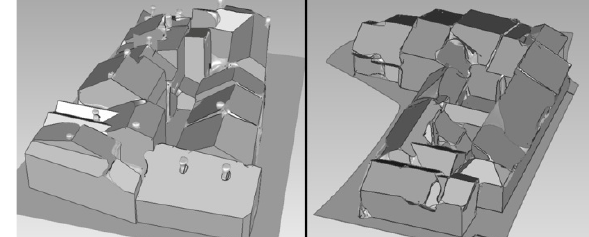
Fig. 8. Results of segmentations from Geomagic for Toul replica scale model, and for the real Epinal scale